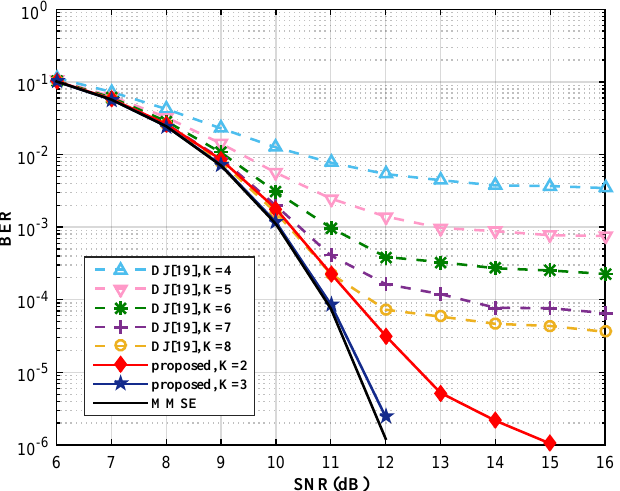
Figure 4. Bit error rate (BER) curves of the damped Jacobi (DJ) algorithm and the proposed Jacobi-based algorithm.